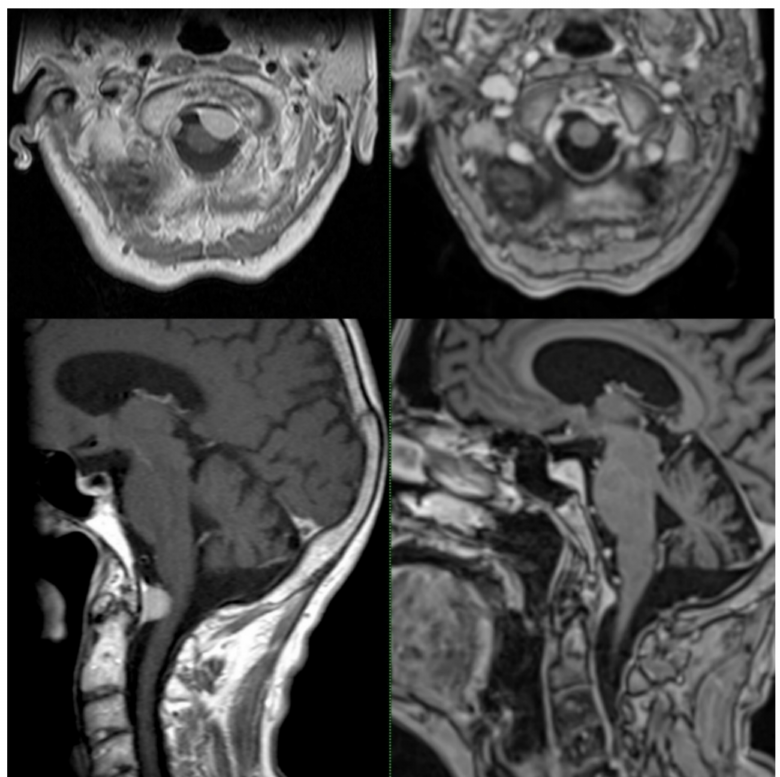
Figure 3. Axial and sagittal pretreatment (left top and bottom) and posttreatment contrast-enhanced MRI (right top and bottom). Incidental finding of a FMM in a 79-year-old man without any neuro- logical findings. To avoid future tumor-associated complications and with respect to the age and comorbidities of the patient, SRS of the FMM was conducted in one session with 13.5 Gy prescribed to the 70% isodose line. After a follow-up of 67 months, the tumor volume decreased from 2.1 to 0.6 cc. No new neurological deficits developed after treatment